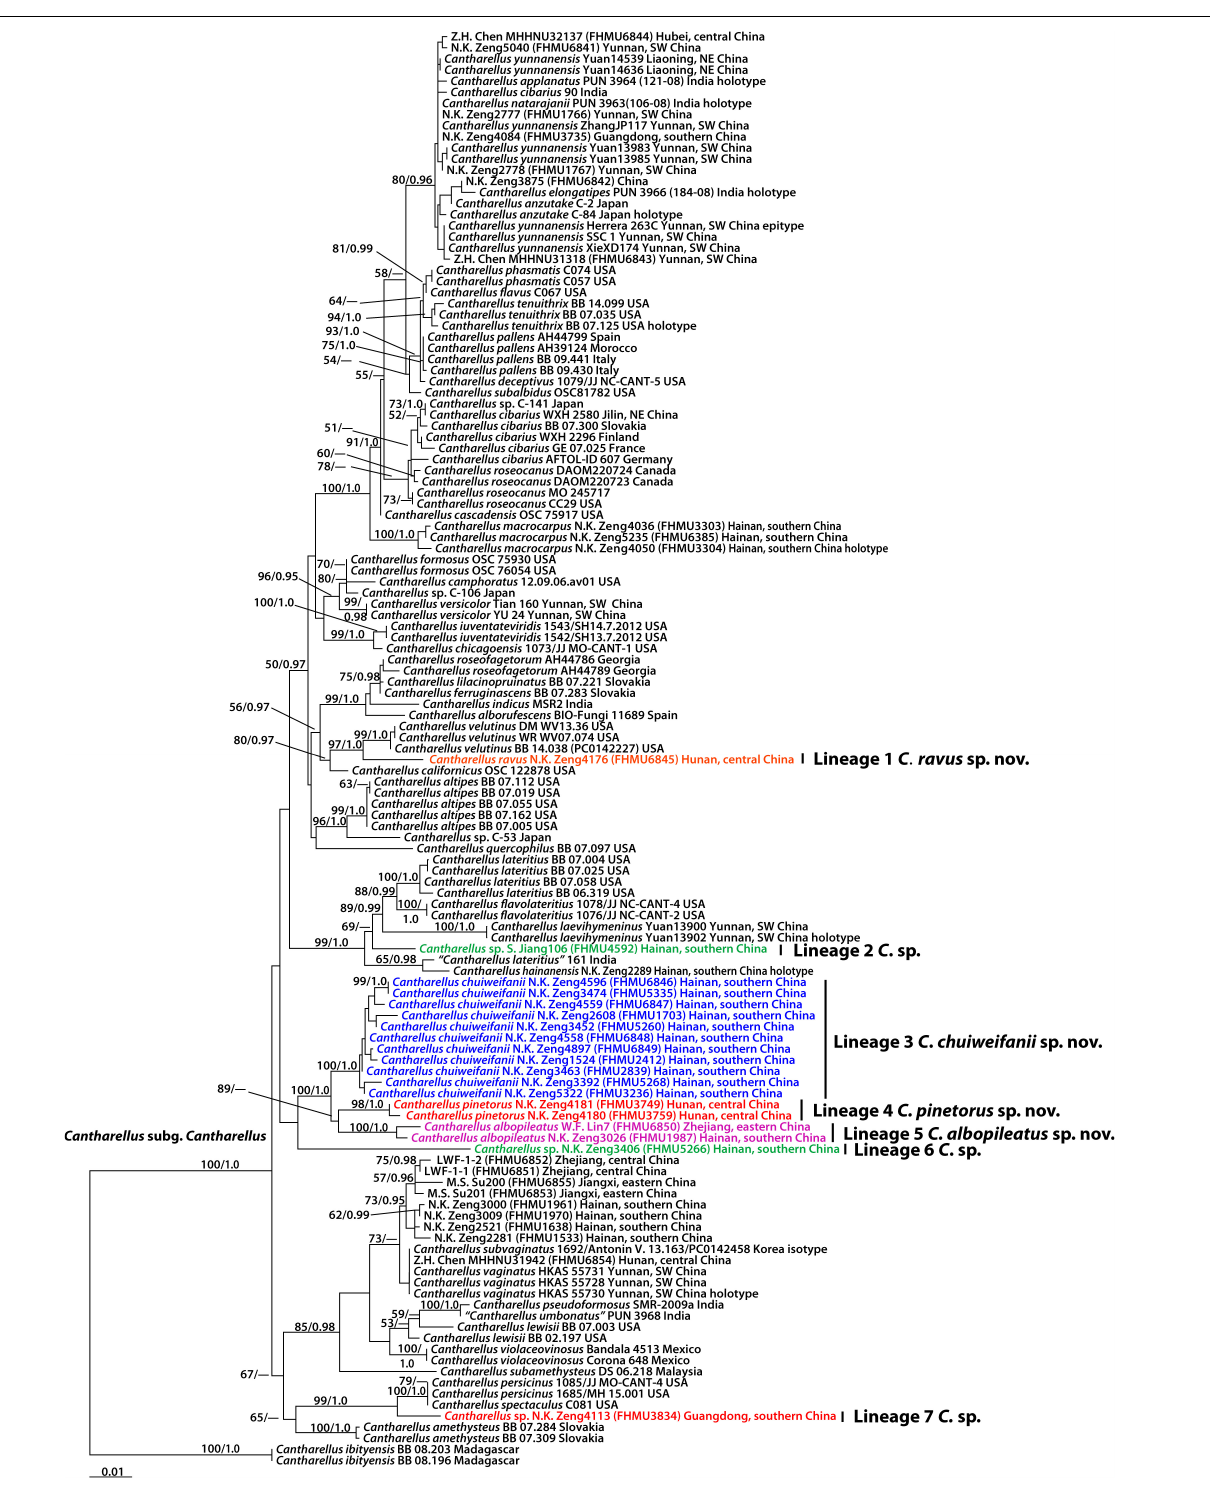
Frontiers in Microbiology |